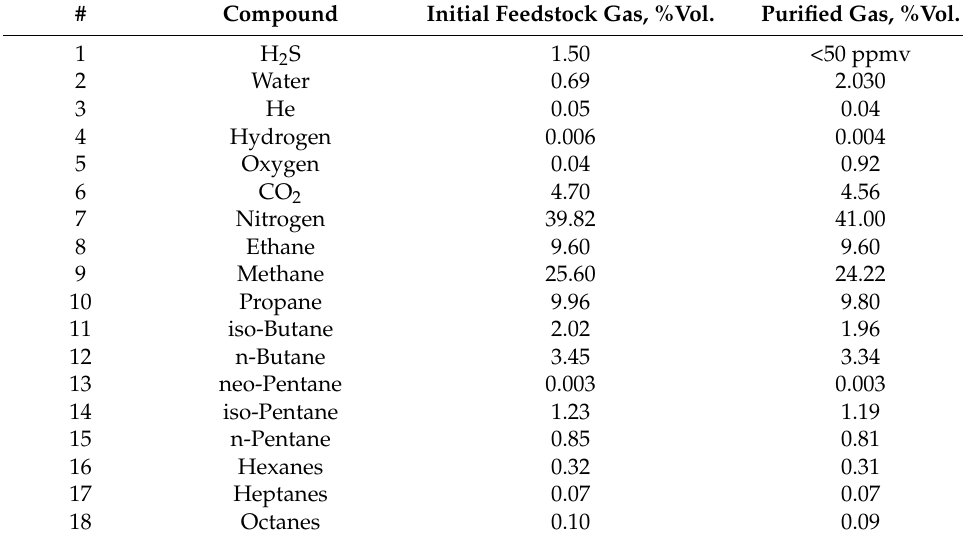
Table 5. GC analysis of initial and purified gas.